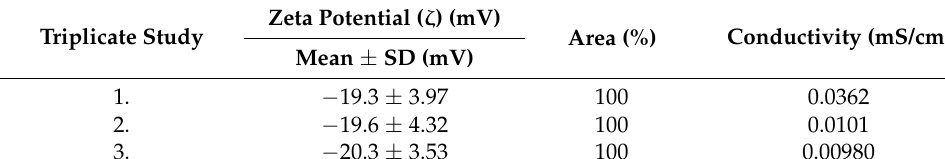
Figure 6. SEM image ( A ) and EDX image ( B ) of Eh-AgNPs.